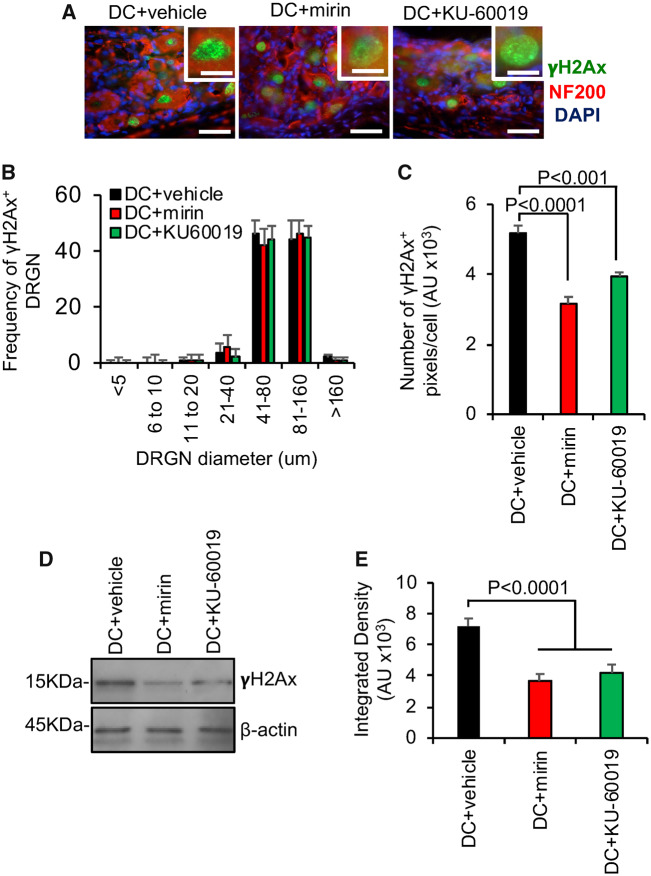

Inhibition of Mre11 and ATM reduces the number of DRGN with double-strand breaks and the levels of γH2Ax after DC injury in vivo. (A) Representative images from DC + vehicle, DC + mirin and DC+KU-60019-treated sections of rat DRGN (n = 6 rats/group, three independent repeats; total n = 18 rats/group) demonstrating γH2Ax (green) localization in the nucleus of DRGN (red). Images are counterstained with DAPI (blue) to demarcate the nucleus. (B) Quantification of the frequency of γH2Ax+ DRGN sorted by different soma size. (C) Quantification of the mean pixel intensity/DRGN in DC + vehicle, DC + mirin and DC+KU-60019-treated DRGN. (D) Western blot and (E) subsequent densitometry to demonstrate reduction of γH2Ax protein levels in DRGN after treatment with mirin and ATM inhibitors. AU = arbitrary units. Comparisons in C and E by one-way ANOVA with Dunnett’s post hoc test. n = 6 rats/treatment, three independent repeats (total n = 18 rats/treatment). Scale bars in A = 50 µm, insets in A = 10 µm.